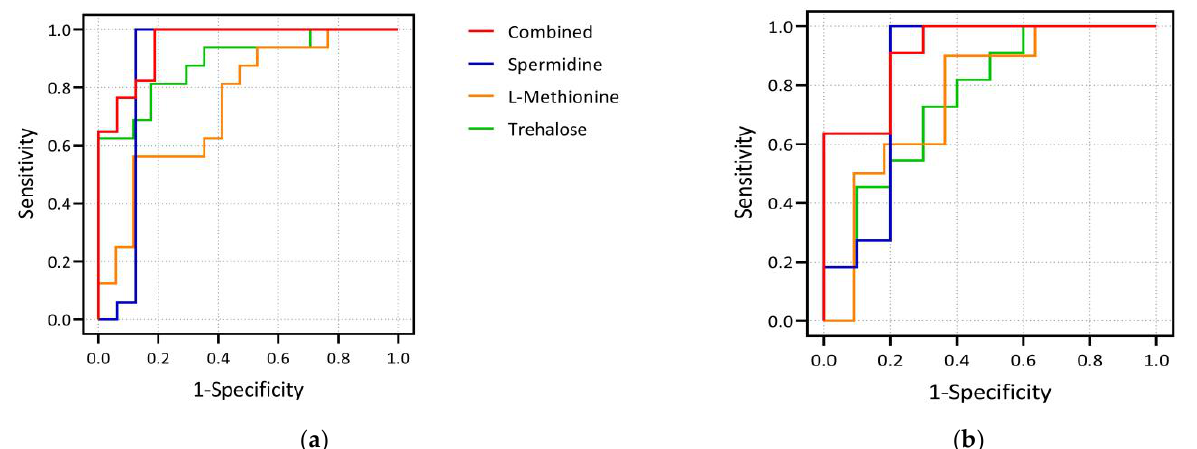
Figure 3. Plots of ROC curve analysis of three differential metabolites. Figure ( a ) shows the ROC curves of spermidine, L-methionine, trehalose and their combination as biomarkers to distinguish GV-H and GV-L groups in the exploration set. The AUCs of spermidine, trehalose, and L-methionine to distinguish the two groups were 0.879, 0.886, and 0.746, respectively, and the AUC of the combination of the three indicators to distinguish the two groups was 0.952. Figure ( b ) shows the corresponding results in the validation set. The AUCs of spermidine, trehalose, and L-methionine to distinguish the two groups were 0.845, 0.764, and 0.764, respectively, and the AUC of the combination of the three was 0.918. It can be seen that the three selected biomarkers in our study, whether used alone or in combination, performed well in distinguishing the GV-H and GV-L groups.